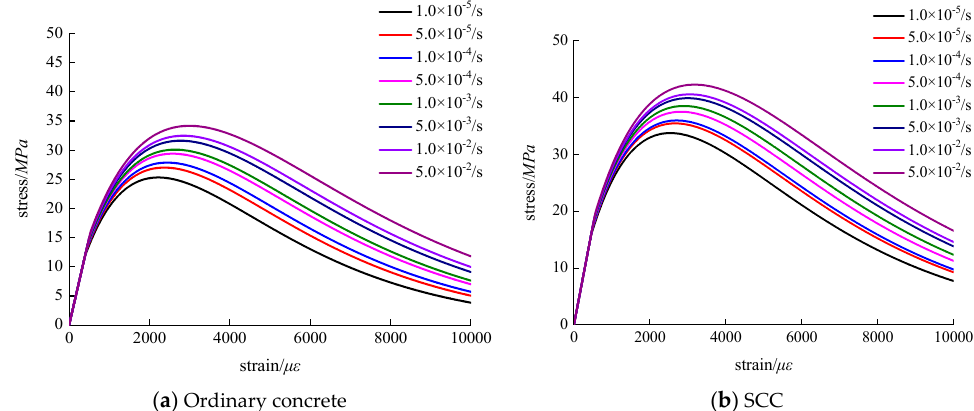
Figure 14. Calculated constitutive relation of elastic–plastic damage of concrete.